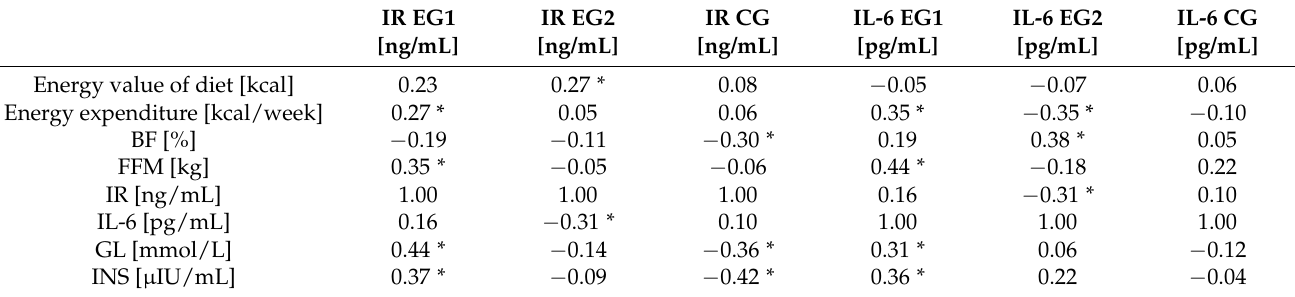
Table 7. Spearman’s rank correlations for participants in the control group (CG), aerobic group (EG1), and aerobic-resistance group